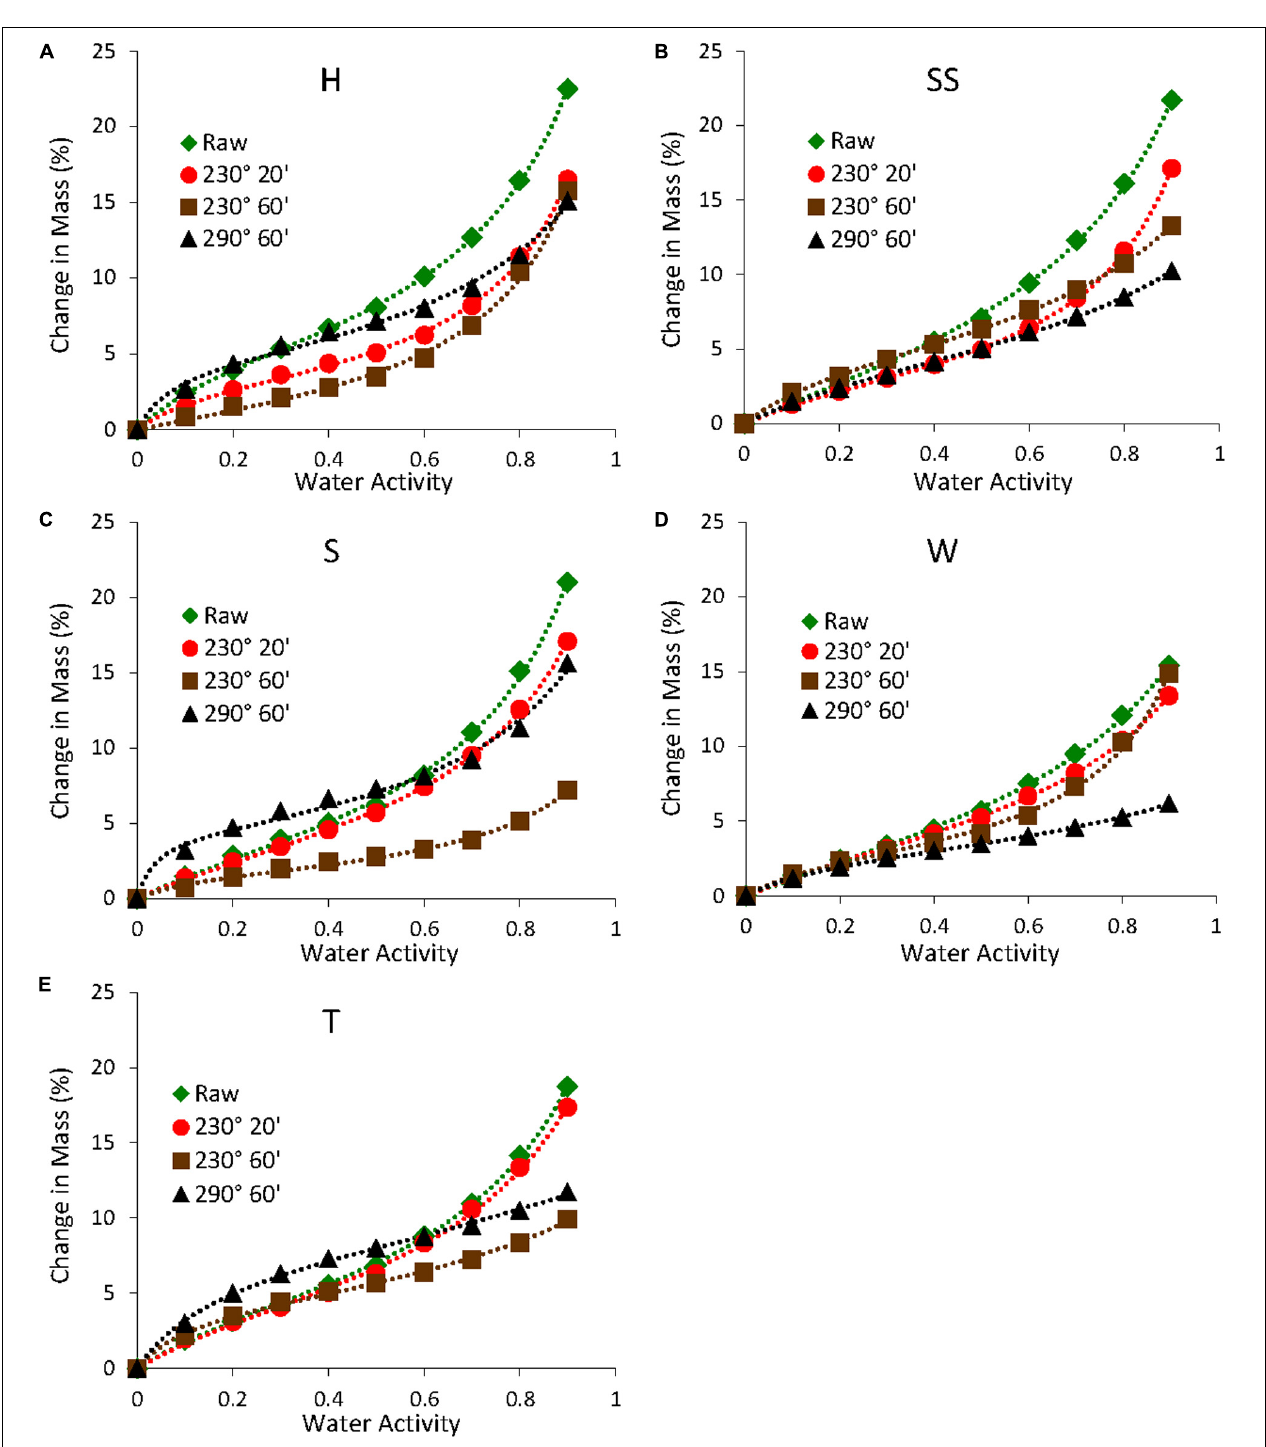
FIGURE 9 | Sorption isotherms of raw and torrefied samples (A) hard shell, (B) semi-soft, (C) soft shells, (D) walnut, and (E) twigs. The dashed lines are fits to the GAB model.